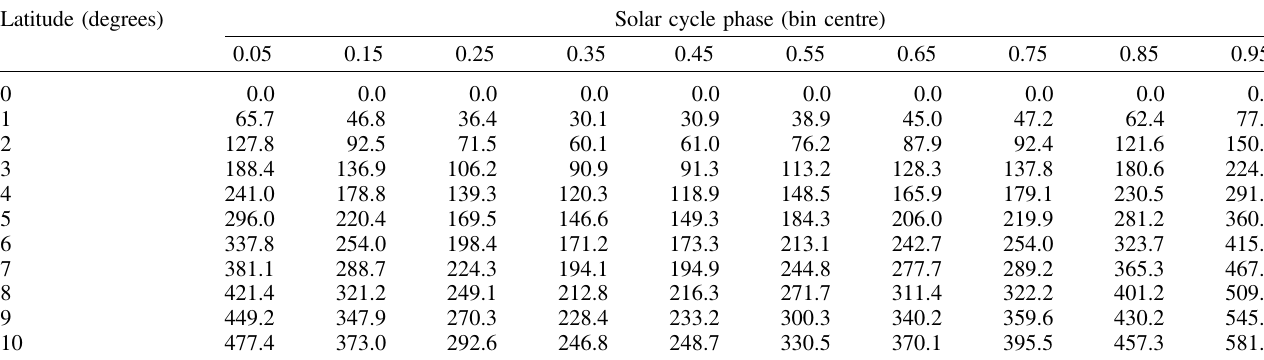
Table 3. The 5-to-95-percentile range of the solar wind speed differences between the equator and other latitudes, i.e. V 0 (cid:3) V h , as a function of solar cycle phase and latitude. All values are given in km s (cid:3) 1